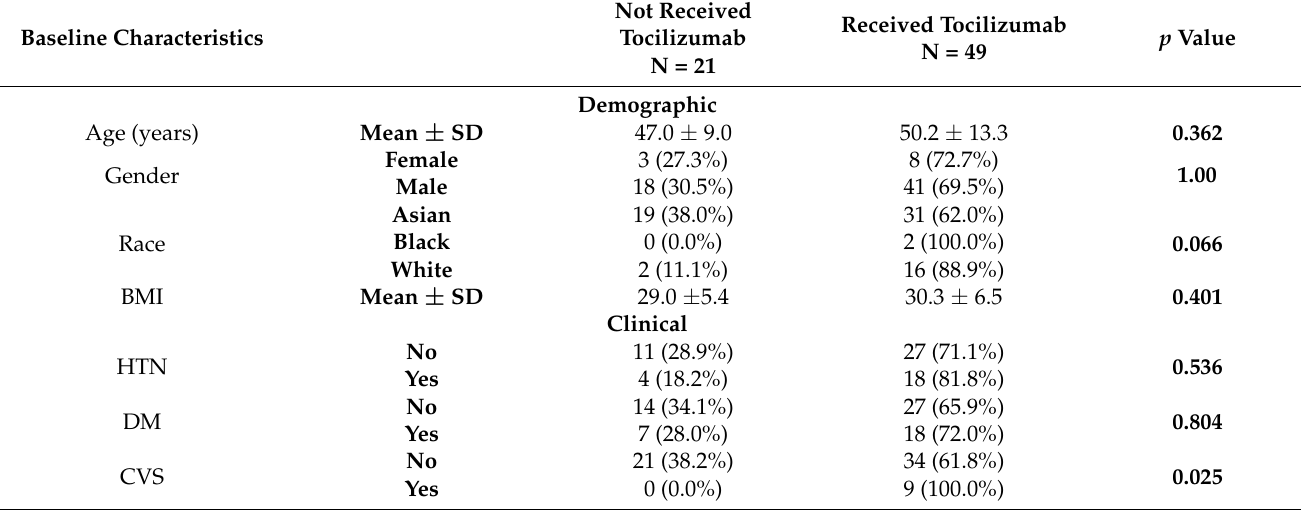
Table 1. Comparative analysis between COVID-19 groups (Received–Not Received) for tocilizumab regarding the demographic, clinical, and biochemical